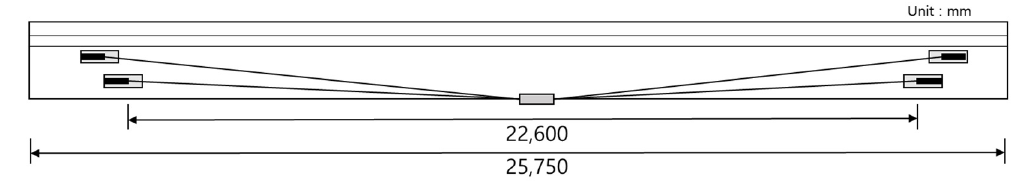
Figure 2. Geometry of specimen reinforced with the external prestressing (EP) method.